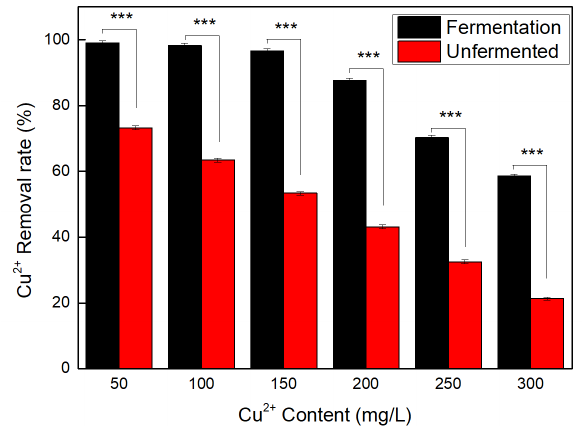
Figure 8: Effect of initial copper ion contents on the removal rates of copper ions using the fermented and unfermented Magnolia officinalis residues (0.2 g of the adsorbent was used, and the adsorption occurred at 30°C with stirring at 120 r/min. The statistical significance difference (p<0.001) is